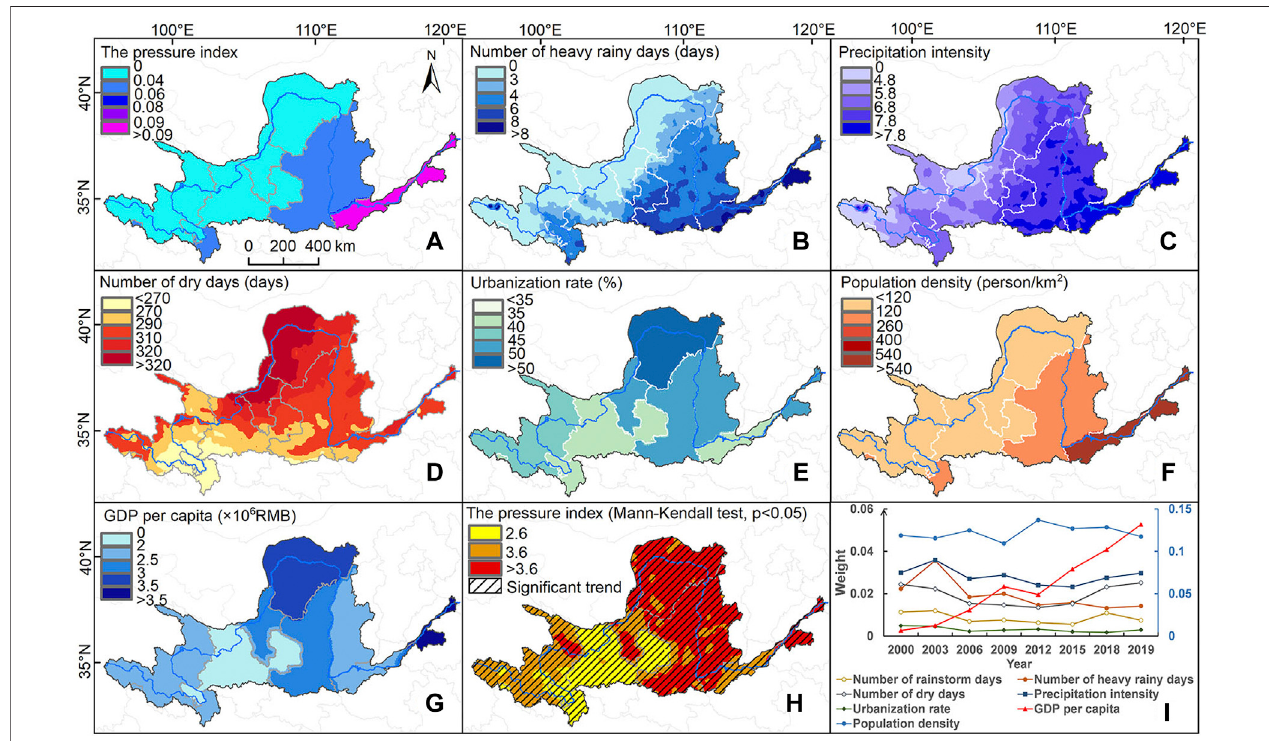
FIGURE2 | Spatial distribution ofpressure index (A) , spatial distribution of pressure layer indicators (B – G) , Mann-Kendall test results ofpressure index at the 0.05 signi fi cance level (H) , the trend of pressure layer indicator weight over time (I) .